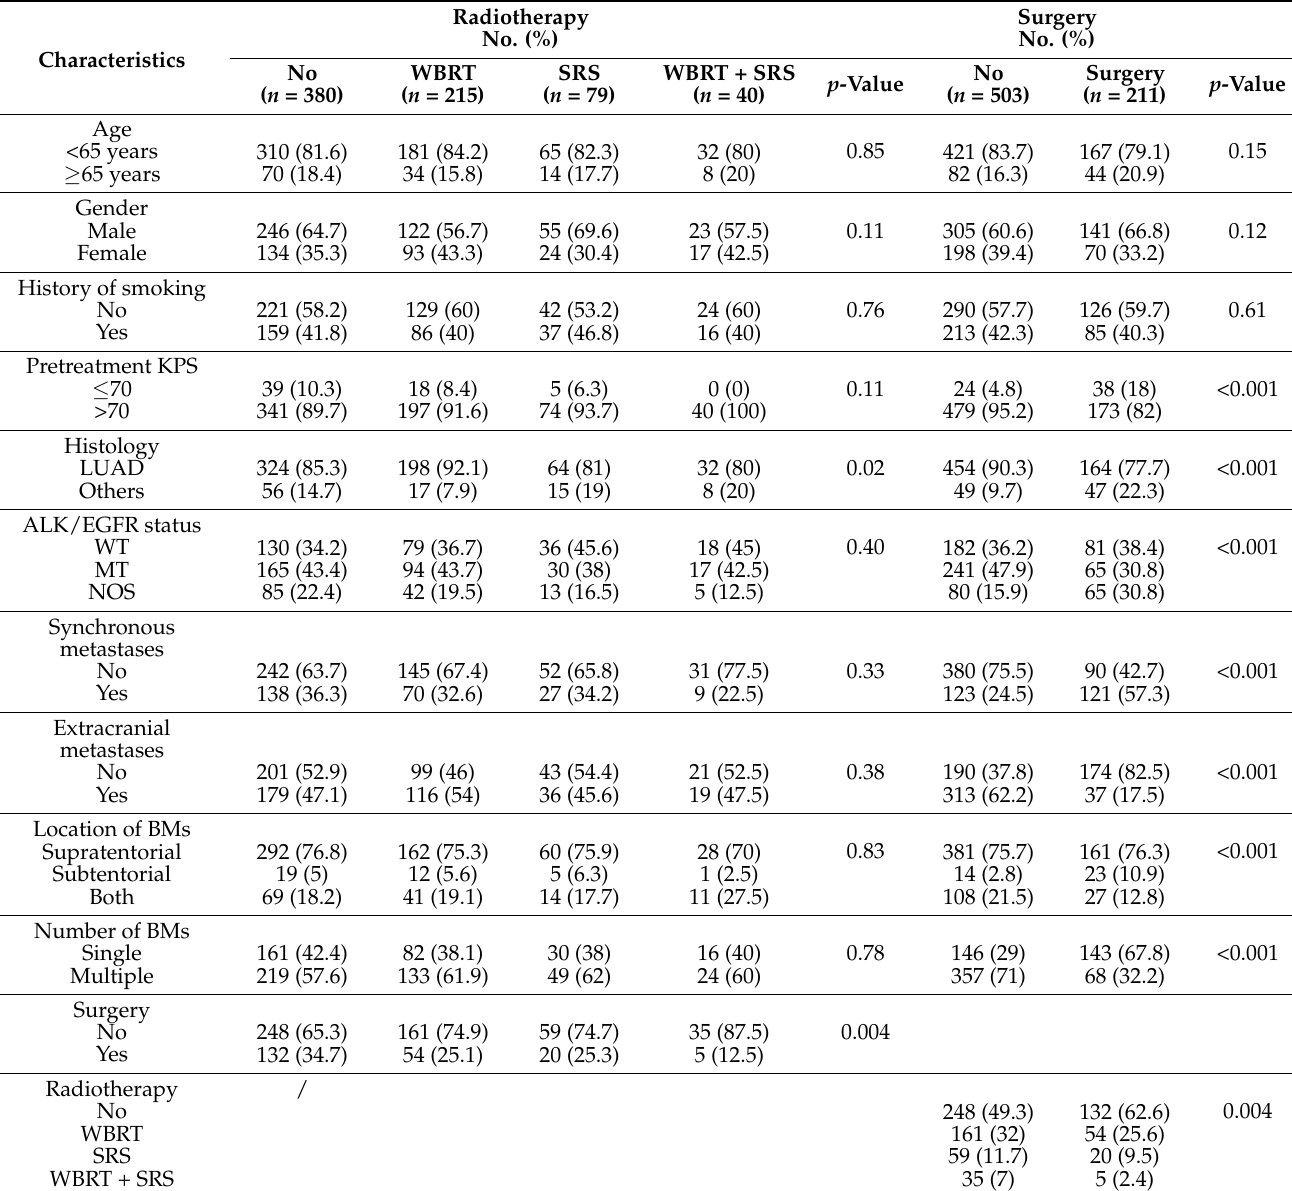
Table 1. Characteristics of patients with lung cancer BMs stratified by surgery or radiotherapy.